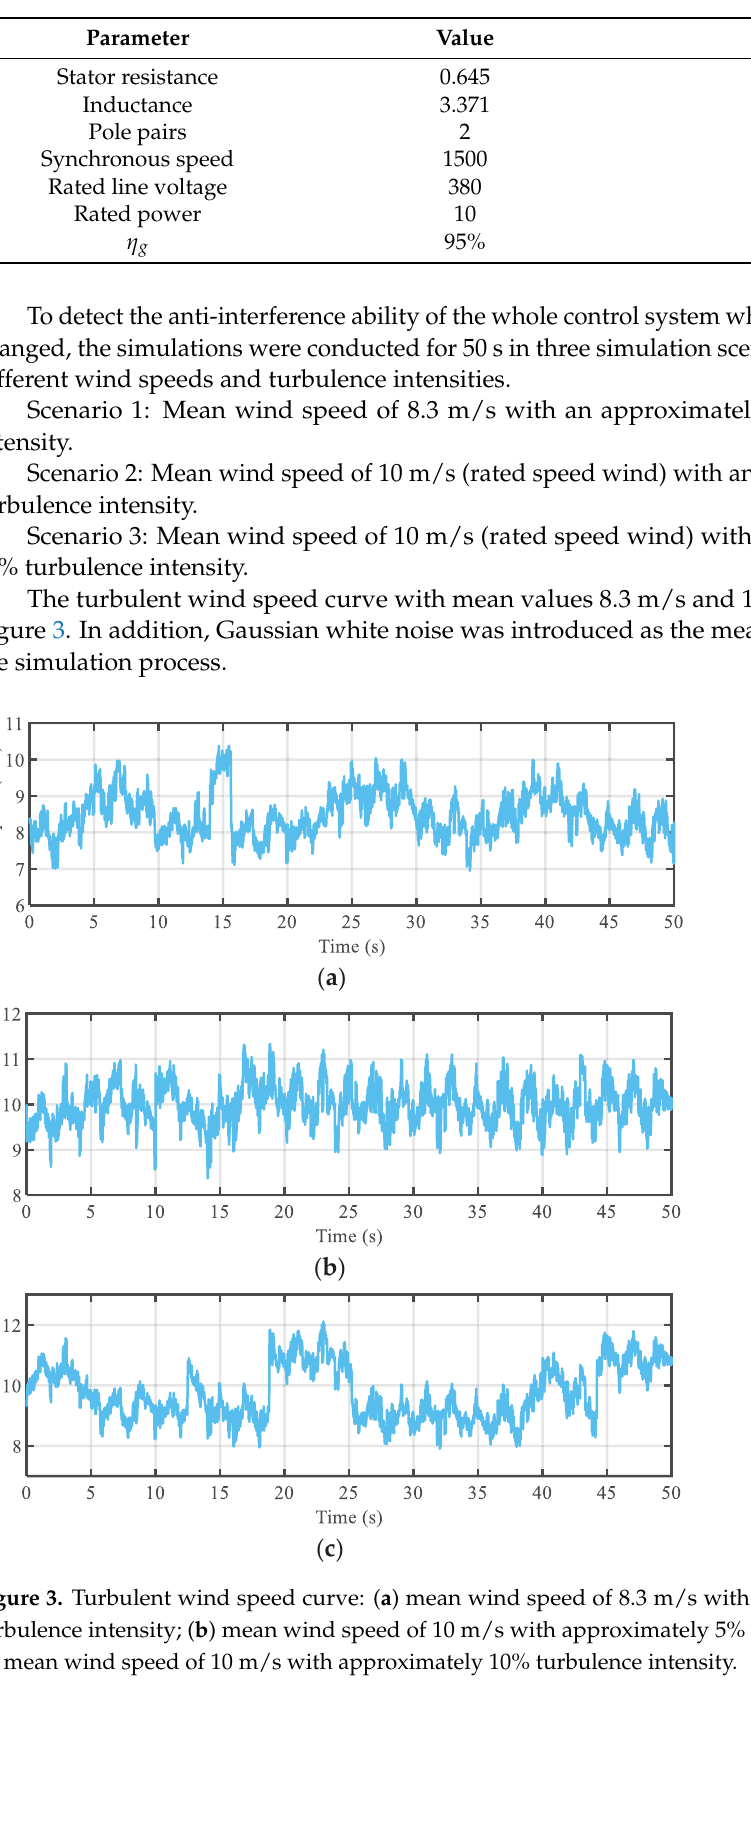
Table 2. Synchronous generator parameters.